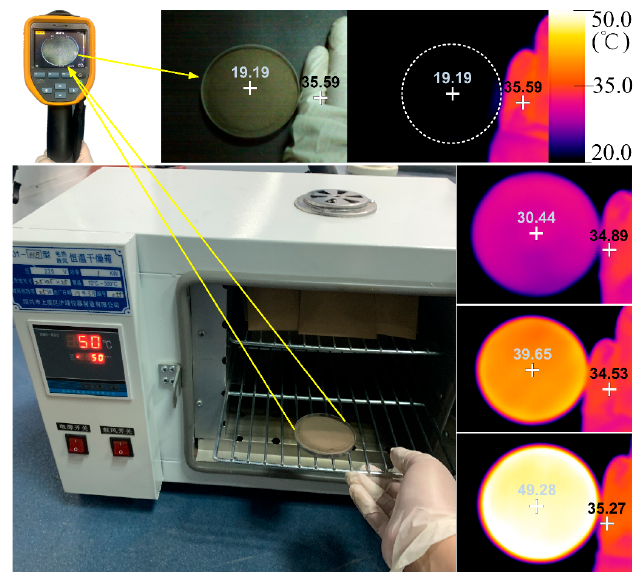
Figure 4. Sample heating and surface temperature recording. The surface temperature of the benchmark sample is represented as the visible light image ( top left ) and infrared image ( top right ). The heated samples are represented as infrared images on the right. The fingers of the researcher are depicted as references.